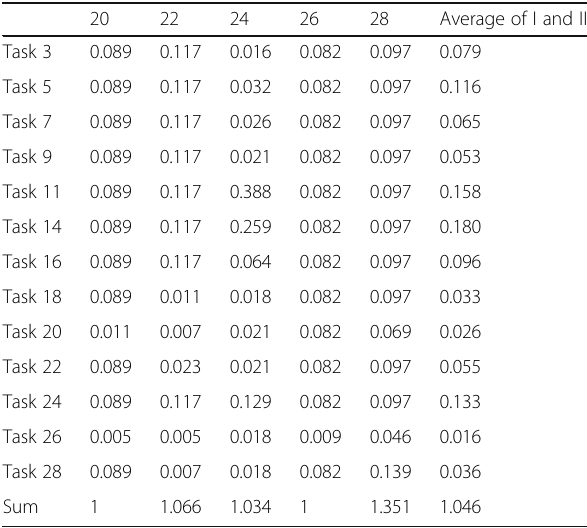
Table 8 Compute weighted sum-II